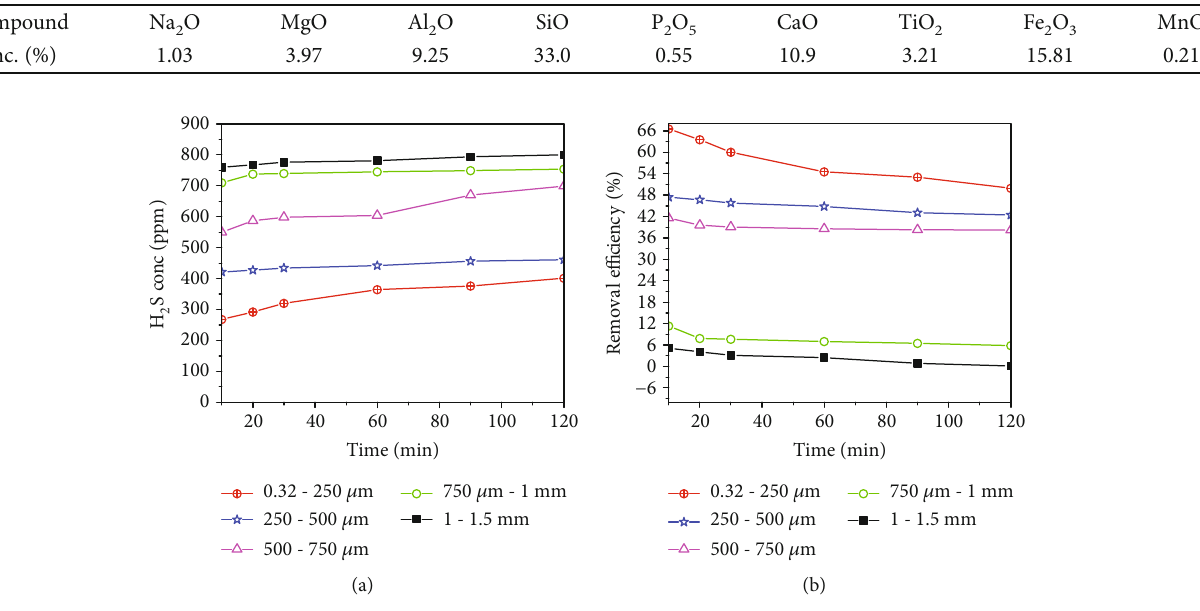
S outlet concentration (left) and removal e ffi ciency (right). 2 = 801ppm , and T = 1000 ° C . o c